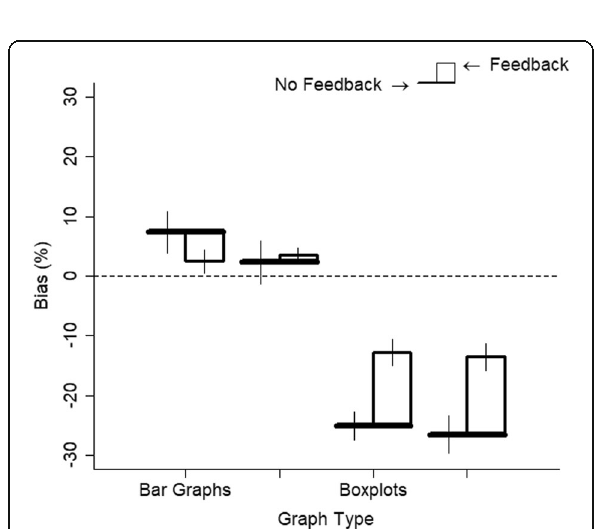
Fig. 19 Bias (calculated as percent overestimation) is potted as a function of graph type and whether there was no feedback (experiment 4) or there was feedback (experiment 5). Positive scores indicate a bias toward overestimating the depicted effect, and negative scores indicate a bias toward underestimating the depicted effect. The brims correspond to the no-feedback conditions and the crowns correspond to the feedback conditions. Error bars are ±1 SEM calculated from separate linear mixed models